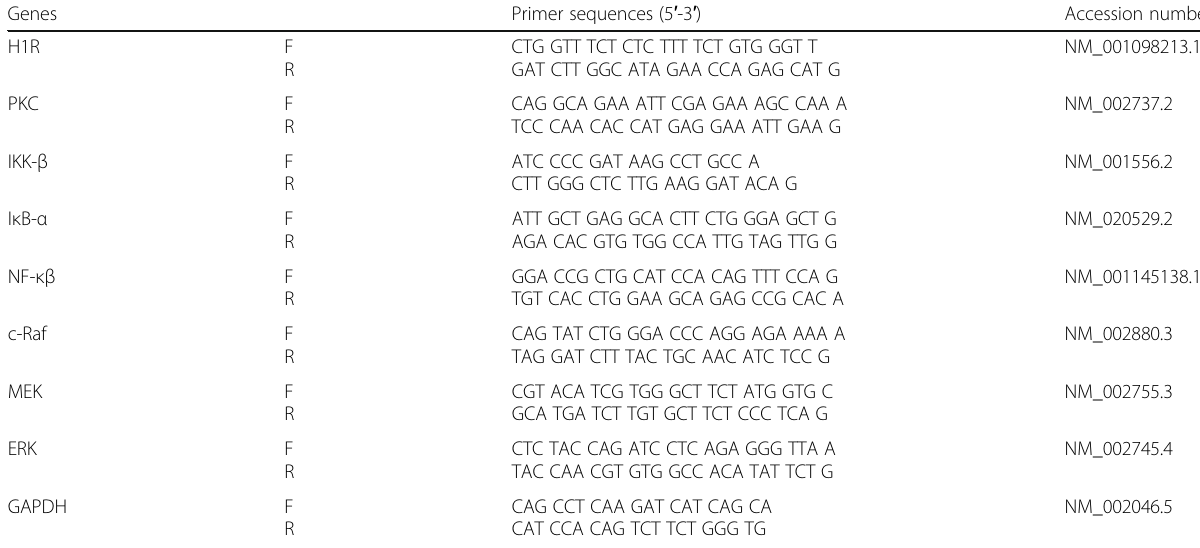
Table 1 Primers sequences of target genes Genes Primer sequences (5 ′ -3 ′